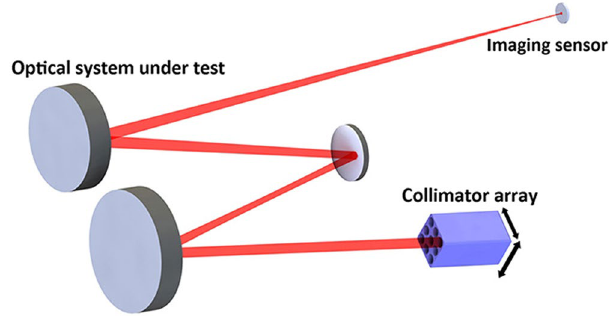
Figure 1. Sketch of the